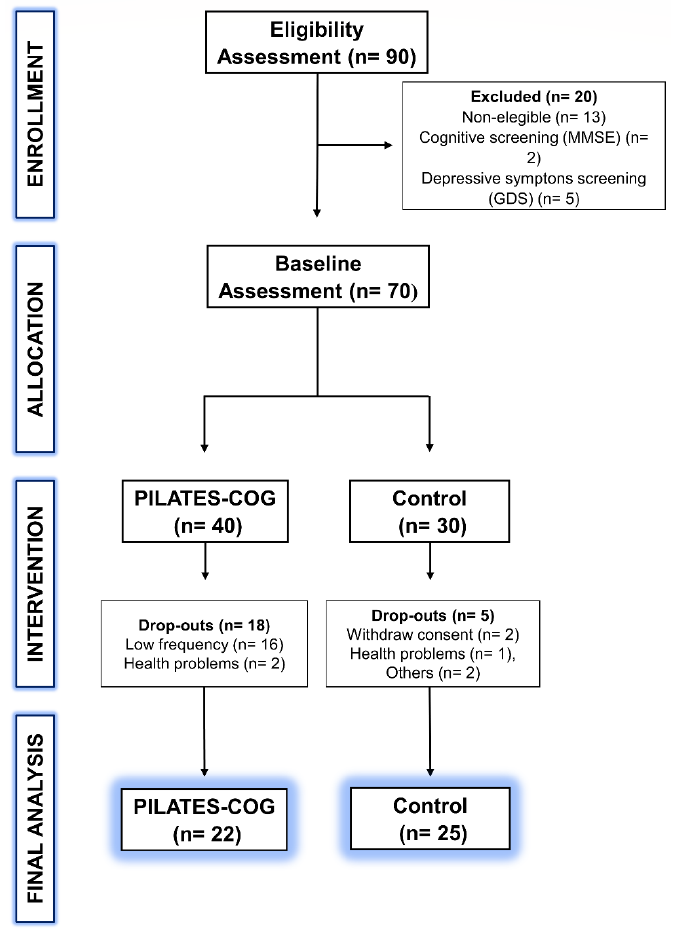
Figure 1. Study Flowchart. Contains information about enrollment, allocation, and inclusion of participants for data analysis.